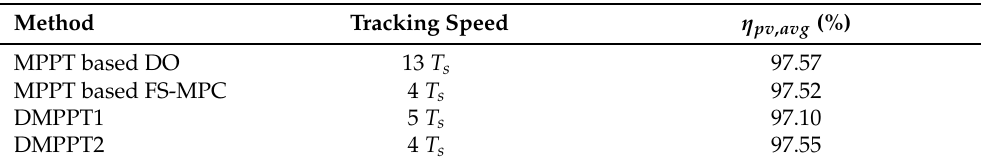
Table 4. Tracking speed and average efficiency of the studied MPPT methods.